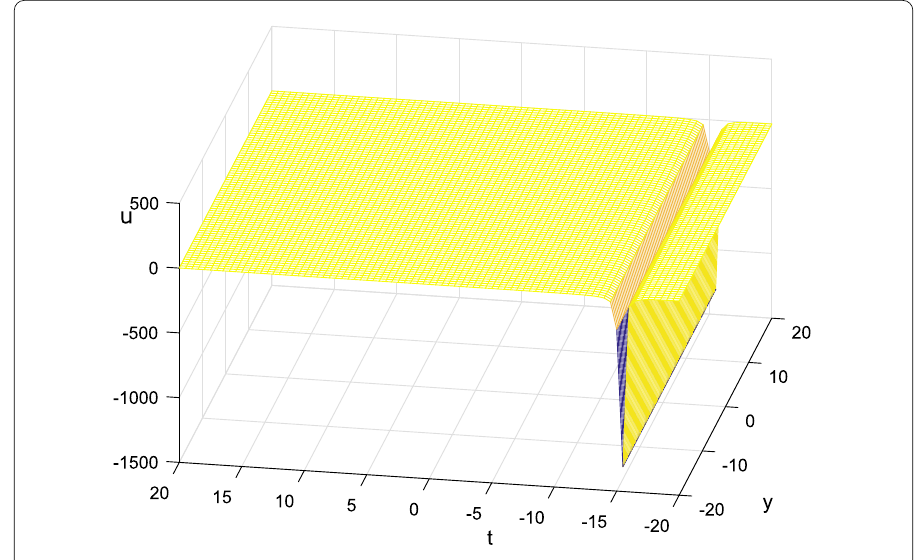
Figure 1 One-periodic solution plot of u ( t , y , n ) for z = 0.6, n = 2, η = 0.1, ˜ ζ 0 = 2, l = 4, p = 0.8, τ = 0.8 i ,